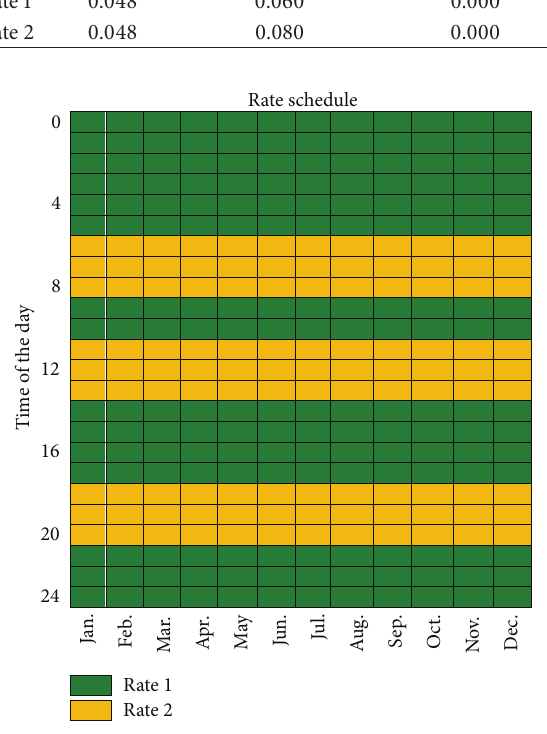
Figure 9: Grid sale and purchase rate schedule (see Table